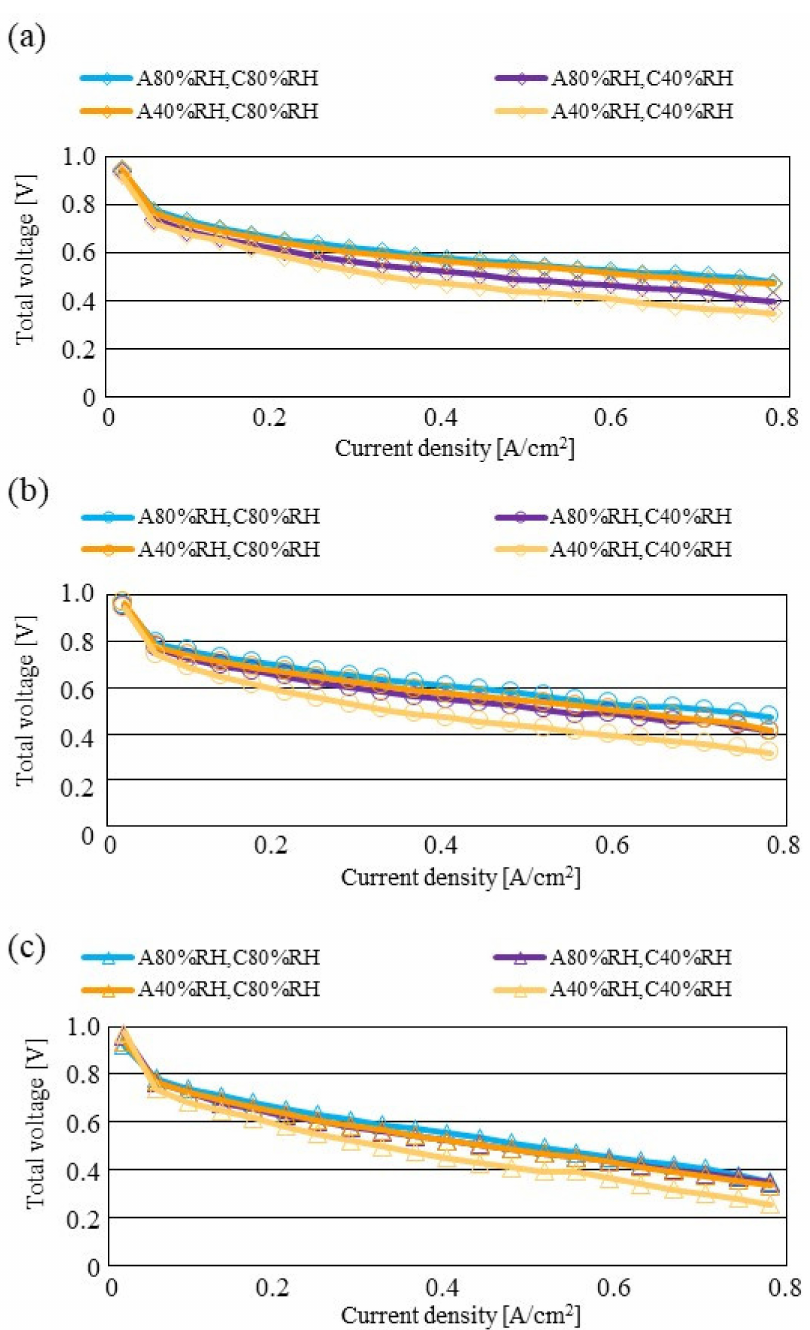
Figure 11. Comparison of polarization curves, among different RHs using the separator thickness of 1.5 mm: ( a ) the initial operation temperature = 80 ◦ C, ( b ) the initial operation temperature = 90 ◦ C, ( c ) the initial operation temperature = 100 ◦